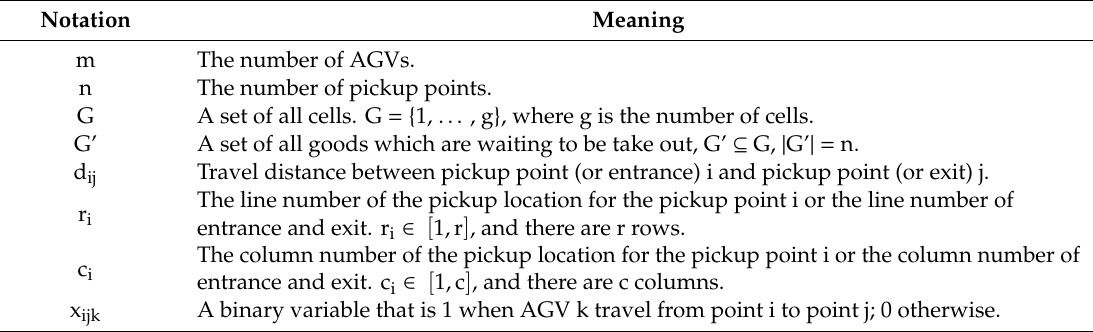
Table 1. Notations and meanings.